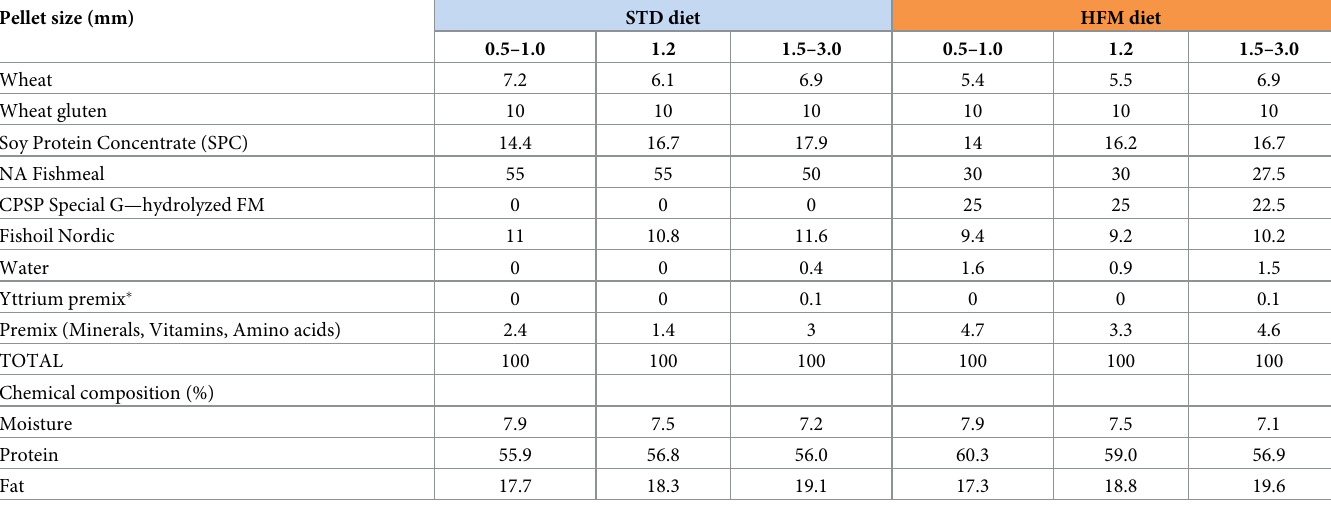
Table 1. Formulation and chemical composition of the diets. Pellet size